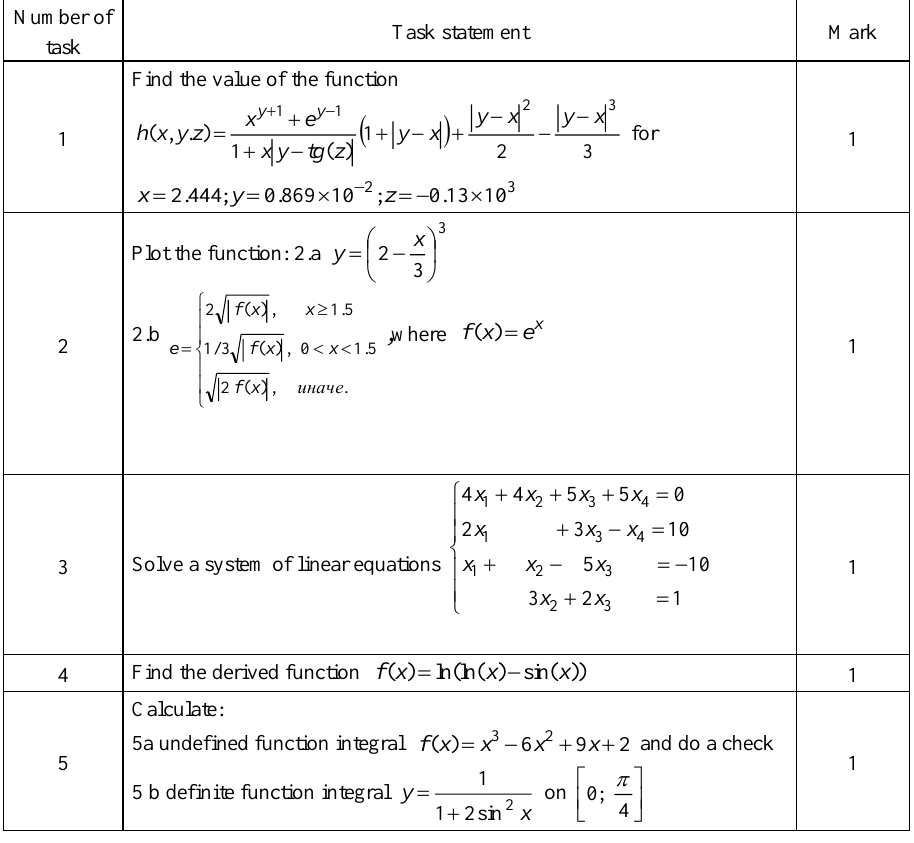
Table 1. Test task